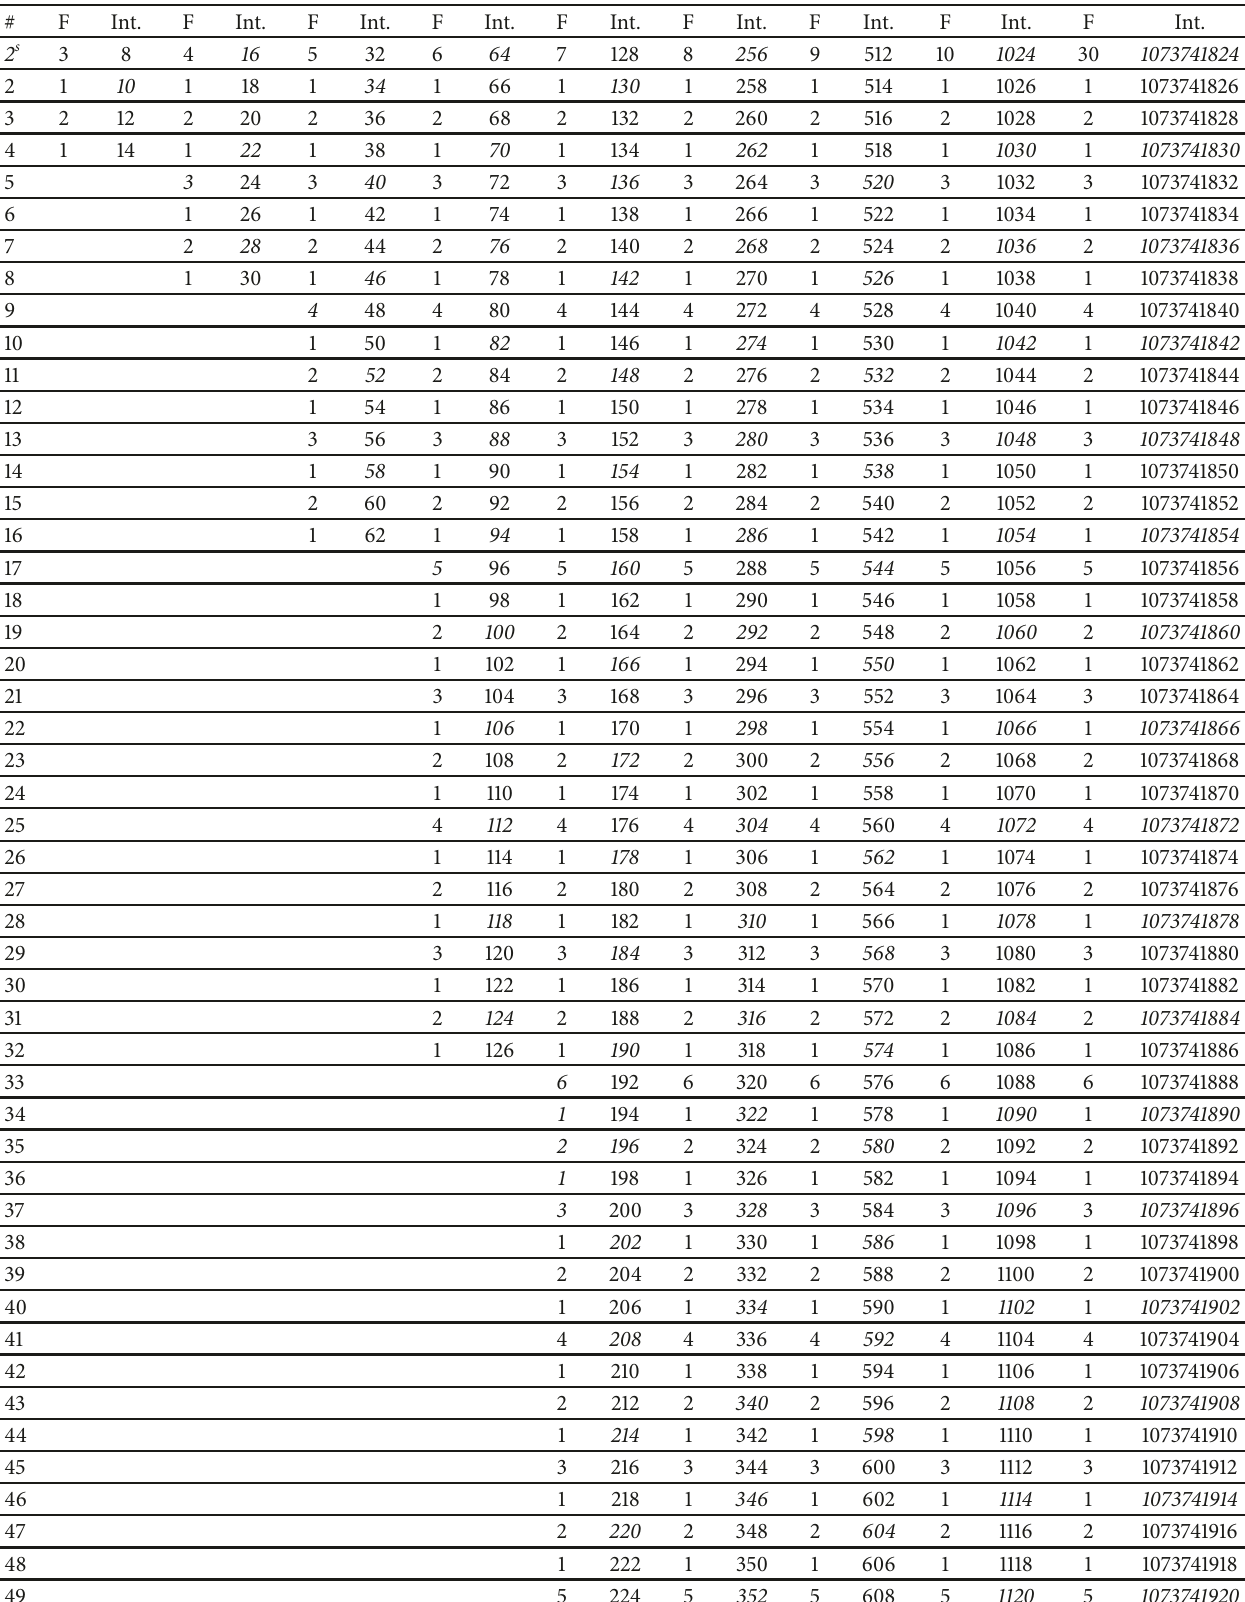
Table 1: Positive even integers and their corresponding frequencies of division by 2. Any row has the same frequency. Even elements of 3𝑛+1 function are in